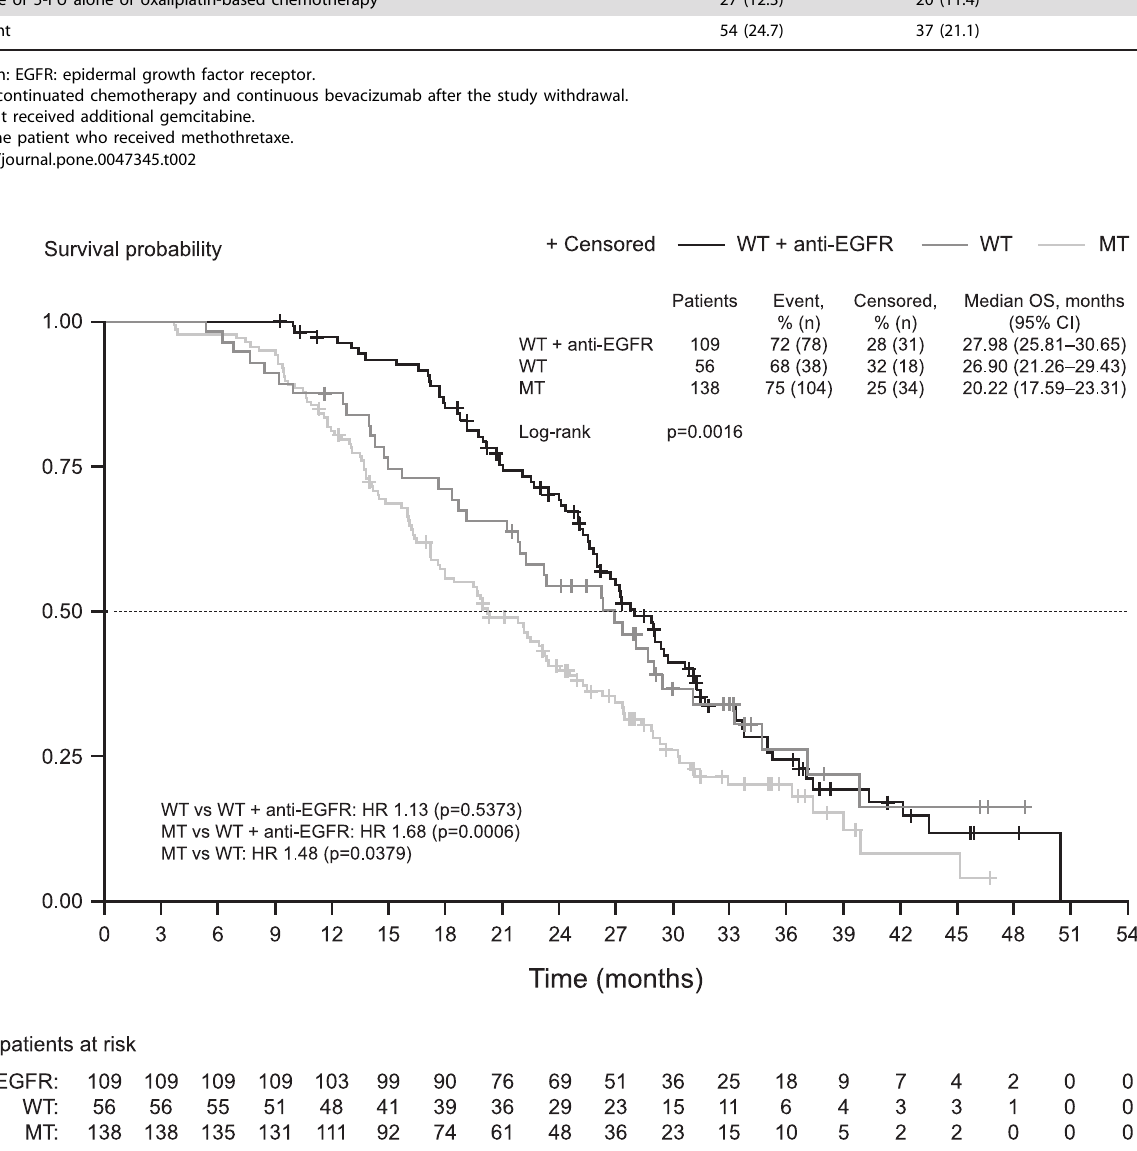
Regimen, n (%) WT KRAS (n=219) MT KRAS (n=175) Anti-EGFR alone 1 ( , 1)